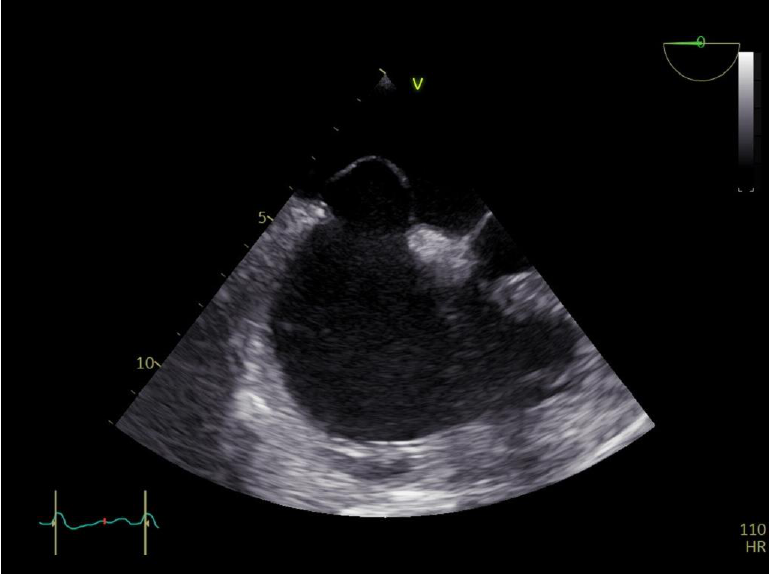
Diagnostics 2022 , 12 , x FOR PEER REVIEW Figure 4. Atrial septal aneurysm. Figure 4. Atrial septal aneurysm.